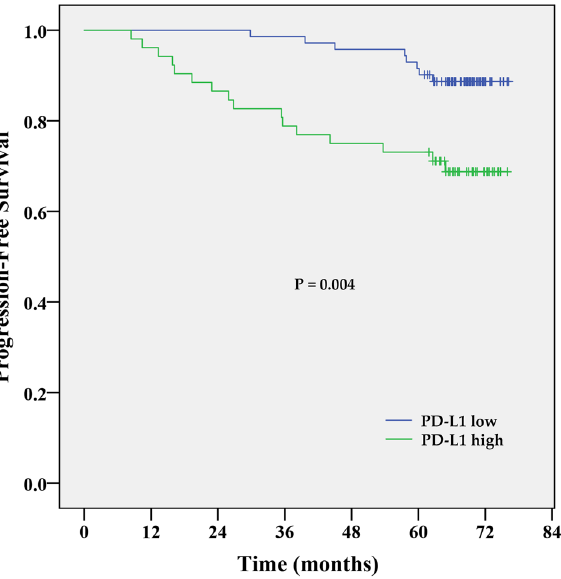
Figure 2. Kaplan–Meier PFS estimates for the PD-L1 expression in the tumour. Patients with high PD-L1 expression had shorter PFS compared to patients with low PD-L1 expression, P = 0.004 by log-rank test.